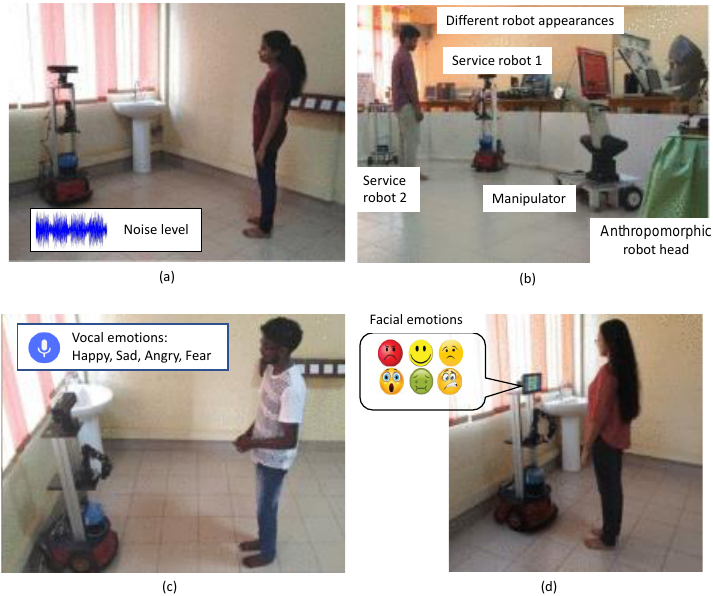
Figure 5. An overview of the HRP study conducted in [49]. ( a ): with internal noise levels of the robot, ( b ): An anthropomorphic robot head, ( c ): A manipulator, and ( d ): A service